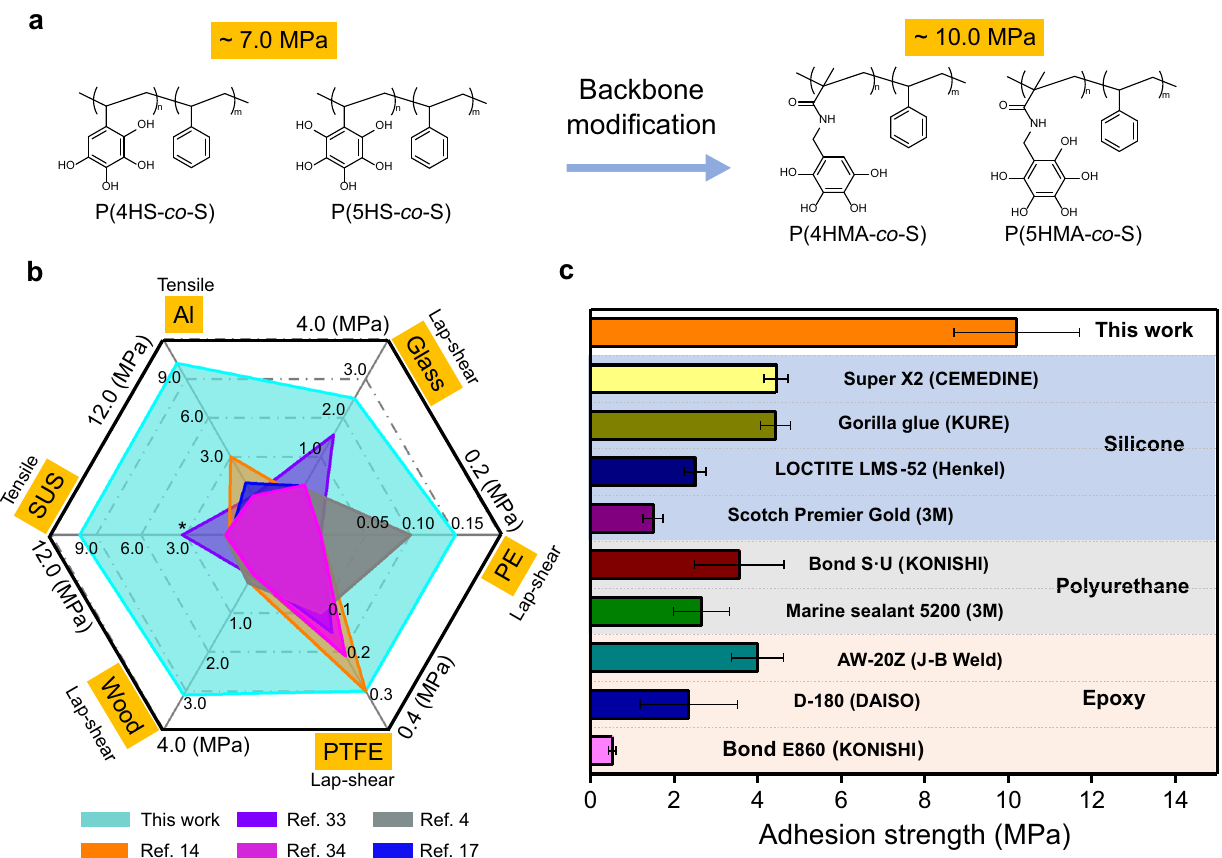
Fig. 4 Benchmarking the multi-phenolic adhesive with commercial and literature-reported ones. a Change of the backbone structure to methacrylic amide further enhanced the underwater adhesion strength. b Comparison of P(4HMA 8% -co -S 92% ) to literature-reported values on various surfaces. c Benchmarking of P(4HMA 8% -co -S 92% ) to typical commercial glues on steel substrates underwater. The results represent the mean ± s.d. ( n = 5). *Results of ref. 33 were performed by lap-shear